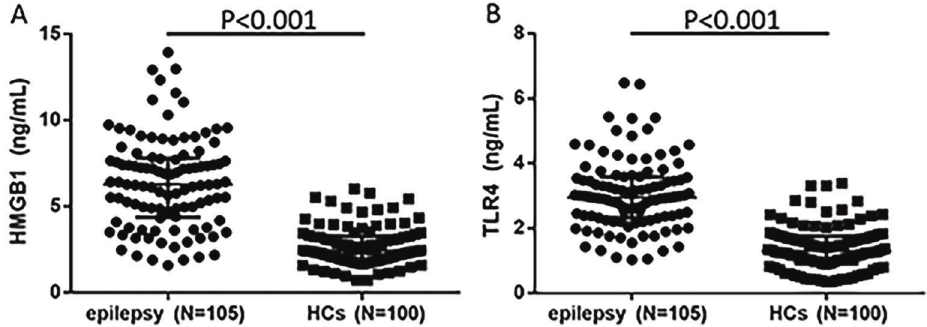
Figure 1. A , Expression of HMGB1 in epilepsy and healthy control (HCs) groups. B , Expression of TLR4 in epilepsy and HCs groups. TLR4, toll-like receptor 4; HMGB1, high-mobility group box-1. Statistical analysis by Mann-Whitney test.